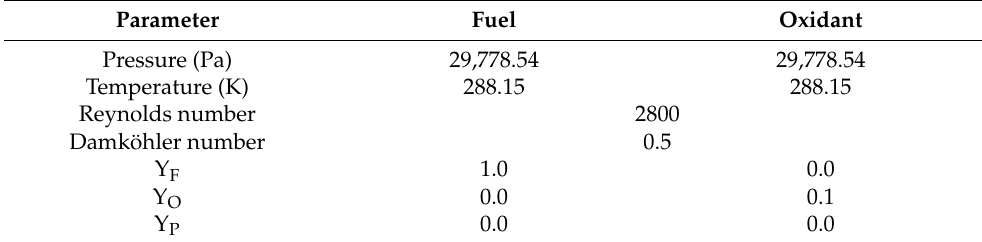
Table 1. Initialization parameters of the reaction